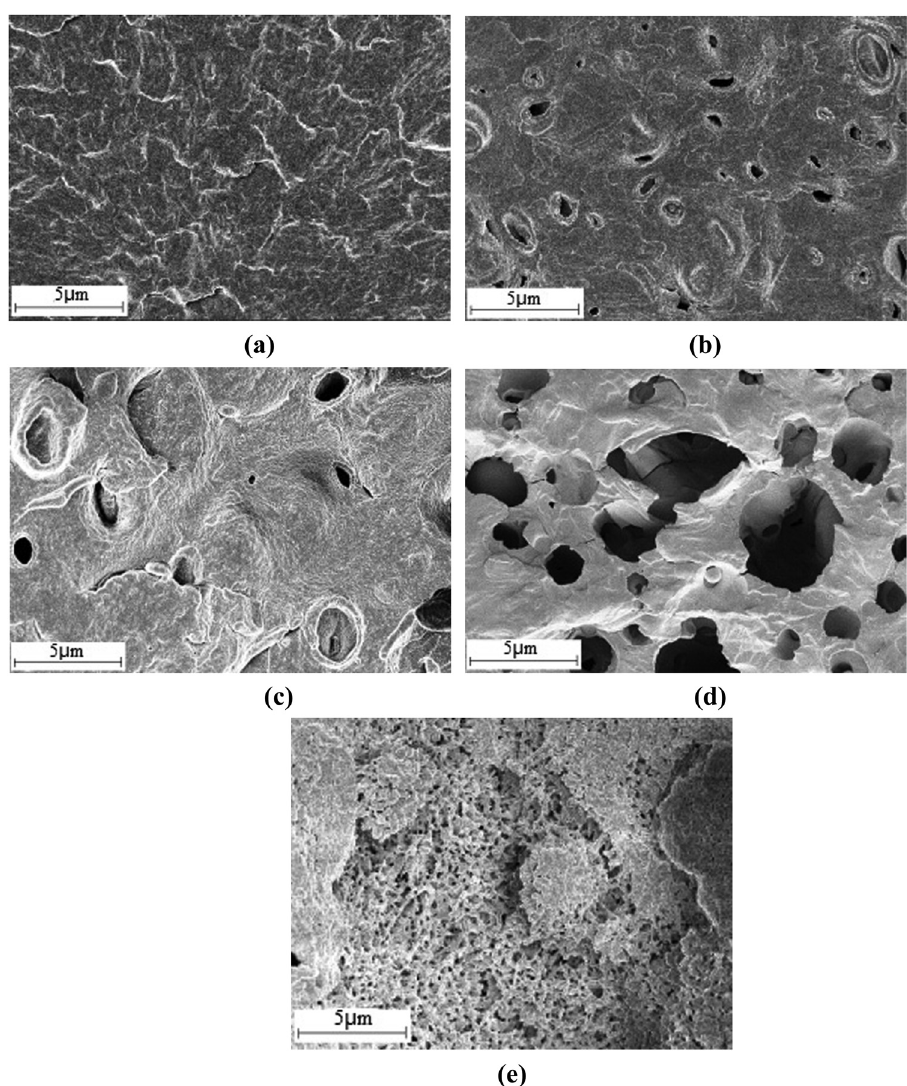
Figure 11: The SEM images of bio - based PA56/PET blends after etching treatment: ( a ) 100% PET, ( b ) 10% bio - based PA56, ( c ) 20% bio - based PA56, ( d ) 30% bio - based PA56, and ( e ) 40% bio - based